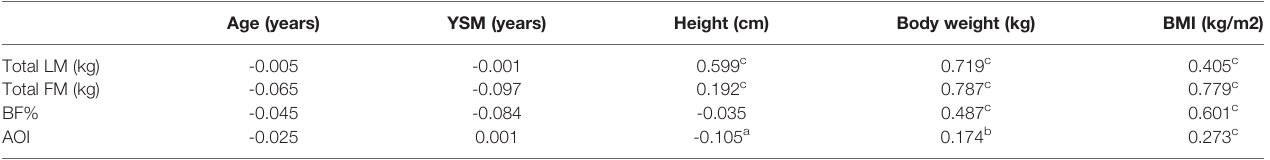
TABLE 3 | Correlation of soft tissue components with anthropometric